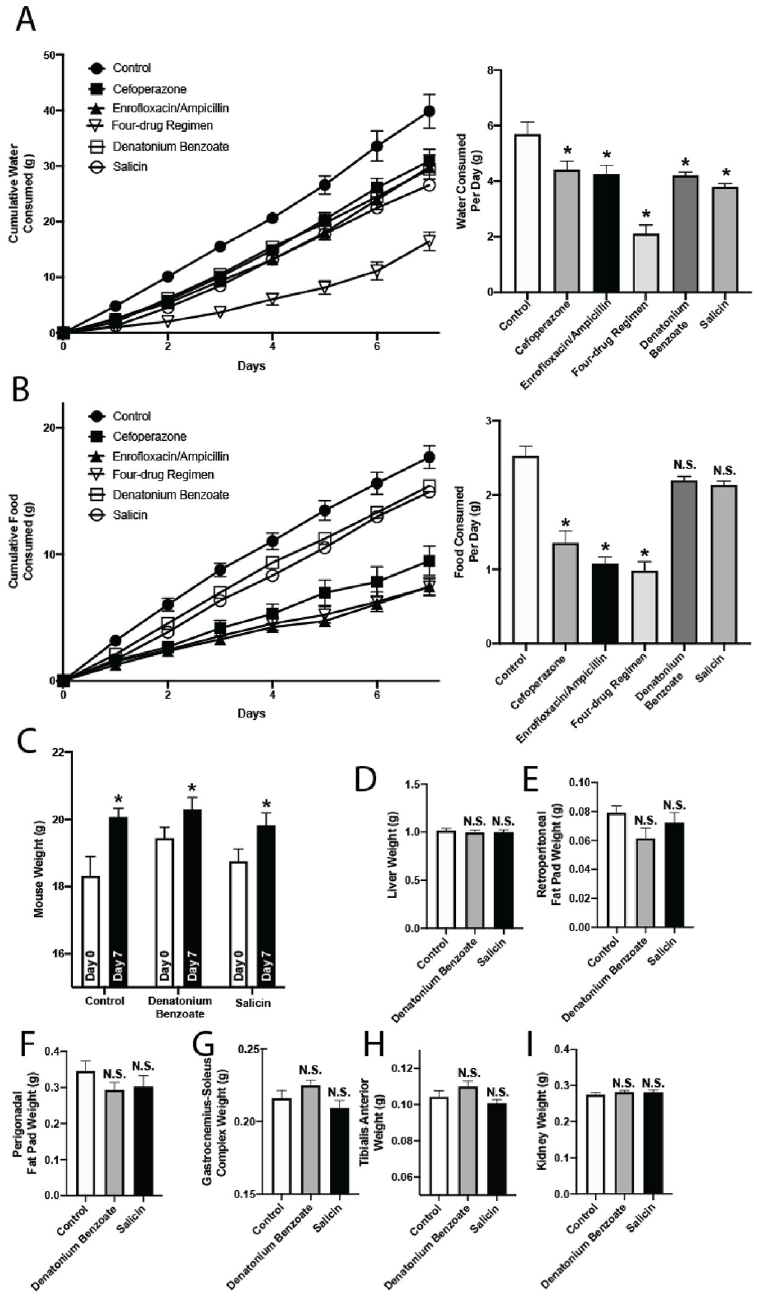
Fig 4. Antibiotic-treated mice exhibit reduced food and water consumption, and this is not explained by bitter taste alone. Mice were treated with cefoperazone, enrofloxacin/ampicillin, or the four-drug regimen in distilled water. Distilled water alone was used for control mice, and antimicrobially-inert but bitter-tasting compounds (3 mM denatonium benzoate or 75 mM salicin) in distilled water were used as positive controls. Mice were provided ad libitum access to food and water. (A) Water consumption. Error bars denote SEM. Left: Cumulative water consumption per mouse. Right: Average water consumed per mouse per day. n = 6–7, � P < 0.05. (B) Food consumption. Error bars denote SEM. Left: Cumulative food consumption per mouse. Right: Average food consumed per mouse per day. n = 6–7, � P < 0.05. (C-I) Mice were treated with denatonium benzoate or salicin in distilled water. (C) Mouse weights were compared at day 0 and day 7 for each treatment. n = 10, � P < 0.05. (D-I) Mice were sacrificed and subject to necropsy on day 8 of treatment and weights of liver (D), retroperitoneal fat pads (E), perigonadal fat pads (F), bilateral gastrocnemius-soleus complex muscles (G), bilateral tibialis anterior muscles (H) and kidneys (I) were compared. n = 10, N.S. denotes non-significance. Error bars denote SEM.